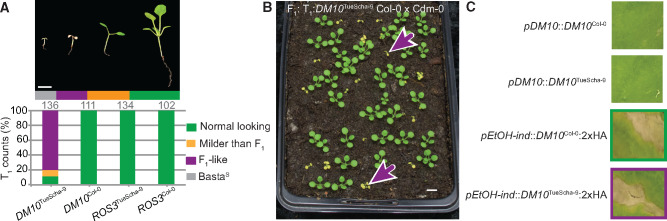
Experimental identification of DM10. (A) Recapitulation of hybrid necrosis in 25-day-old Cdm-0 T1 plants transformed with the indicated genomic fragment from TueScha-9 or Col-0. Representative phenotype and total number of T1 plants examined given on top. Plants were grown at 16 °C. Scale bar represents 1 cm. (B) The same DM10TueScha-9 genomic fragment as in (A) was introduced into Col-0, and T1 plants were crossed to Cdm-0. The F1 hybrid phenotype was recapitulated (magenta arrows). Plants were 18 days old and grown at 16 °C. Scale bar represents 1 cm. (C) Infiltration of Nicotiana benthamiana leaves with the indicated constructs. Overexpression of either DM10TueScha-9 or DM10Col-0 under an EtOH-inducible promoter (pEtOH-ind) triggered cell death, whereas expression from their native promoter (pDM10) did not. Images were taken 7 days after infection.